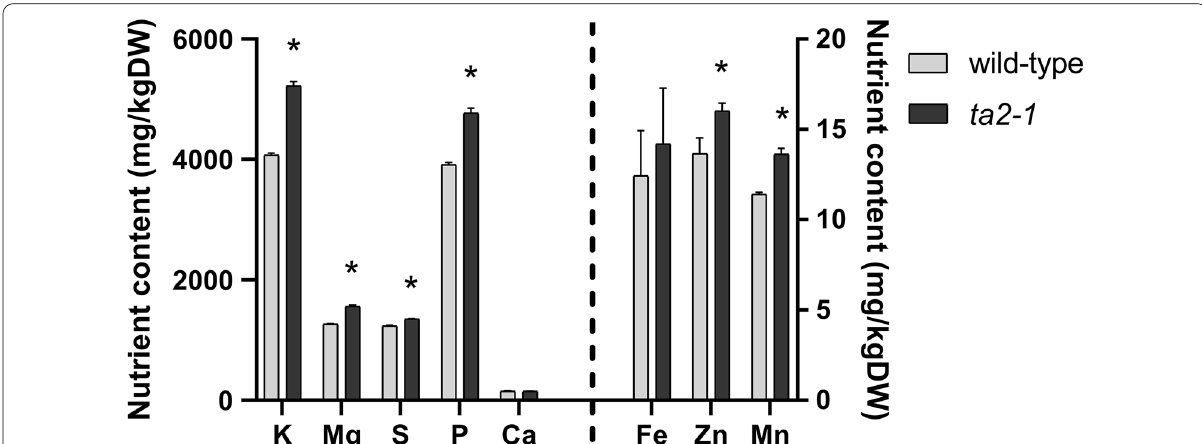
Fig. 10 Minerals comparison. Potassium (K), Magnesium (Mg), Sulphur (S), Phosphate (P), and Calcium (Ca) content in the left panel follows the primary y‑axis ranging from 0 to 6000 mg/100gDW (dry weight); Iron (Fe), Zinc (Zn), and Manganese (Mn) content in the right panel follows the secondary y‑axis ranging from 0 to 20 mg/100gDW (* P < 0.05; ANOVA, Tukey’s HSD test; K, Mg, S, P, Ca, Fe, Zn, and Mn, n